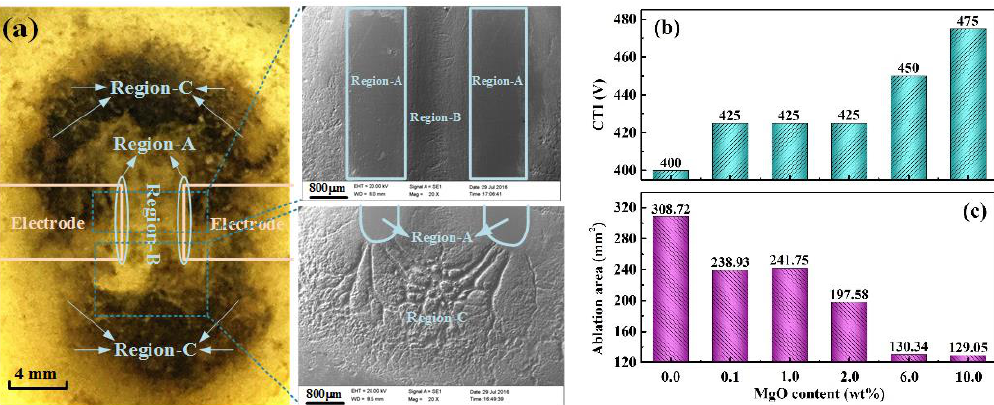
Figure 3. Typical surface morphology of the epoxy samples, after the tracking measurement, with enlarged SEM pictures for the tree regions ( a ). The corresponding comparative tracking index (CTI) ( b ) and ablation area after 50 droplets, at a fixed voltage of 425 V ( c ) for samples with different nanofiller contents.